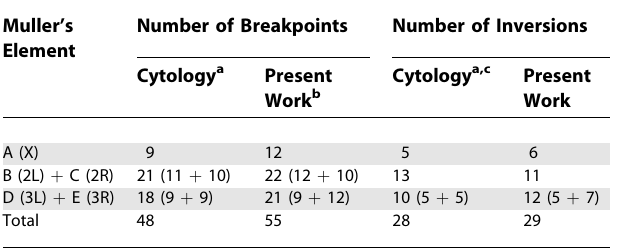
Table 2. Magnitude of Chromosomal Change between D. melanogaster and D. yakuba for the Different Muller’s Chromo- somal